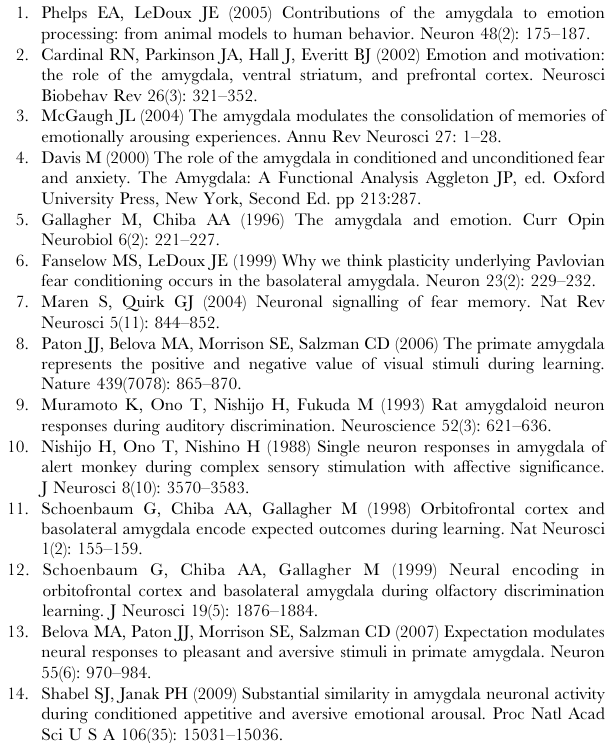
Figure S1 Speed of intraoral infusions. The infusion rates of three lines were calculated by averaging the rates of ten infusions per line. The smoothed averages are shown here. The